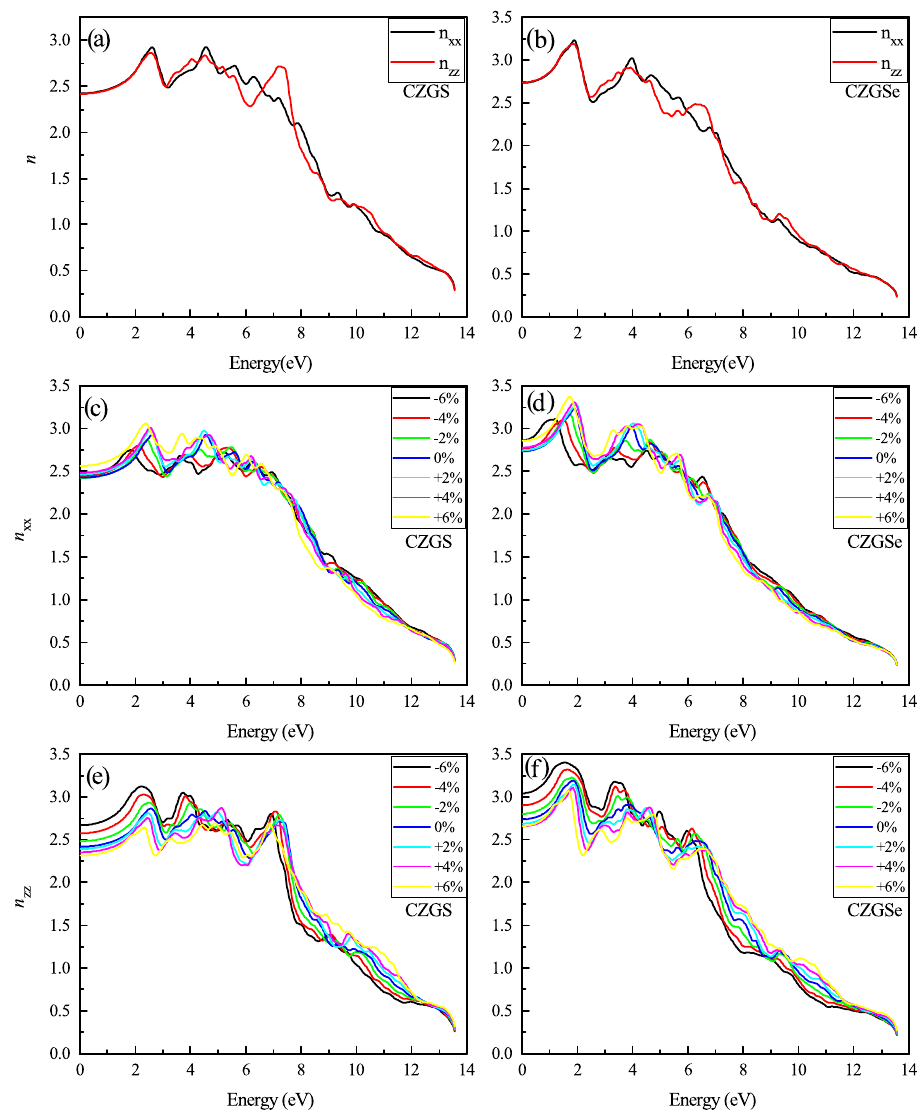
Figure 14. The variation of the refraction index spectra as a function of the incident photon energy for both materials CZGS and CZGSe: ( a , b ) are the unstrained cases, ( c – f ) are the strained cases. R xx and R zz are the refraction index for light polarization along XX and ZZ directions respectively.